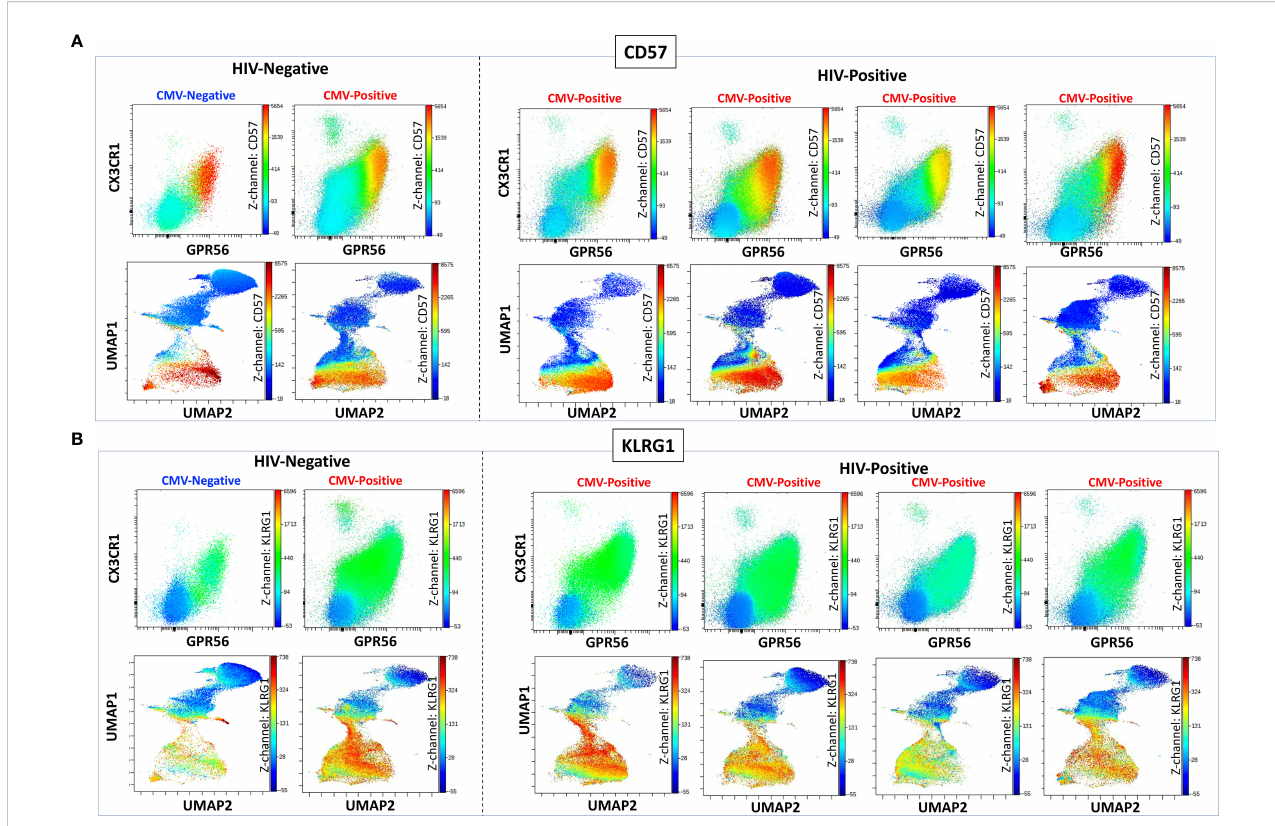
FIGURE 1 CGC + CD8 + T cells express CX3CR1 and GPR56 with variable expression of CD57. The two-dimensional fl ow cytometry panel shows the co-expression of CX3CR1 and GPR56 and highlights CD57 expression on these cells compared to non-CGC + T cells. UMAP shows CGC + CD8 + cluster and variable expression of CD57 (A) . KLRG1 expression on CGC + CD8 + T cells is demonstrated by two-dimensional plots and UMAP (B) . Participants in this analysis included two HIV-negative persons with and without CMV, and four CMV-positive